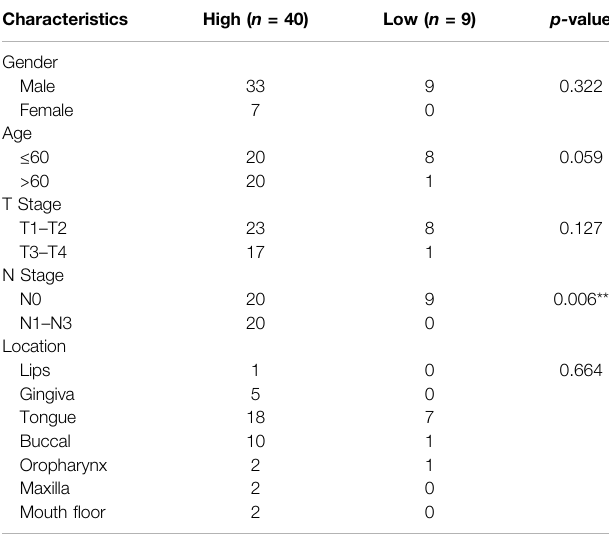
TABLE 1 | Information on HNSCC patients and association with MANCR expression.